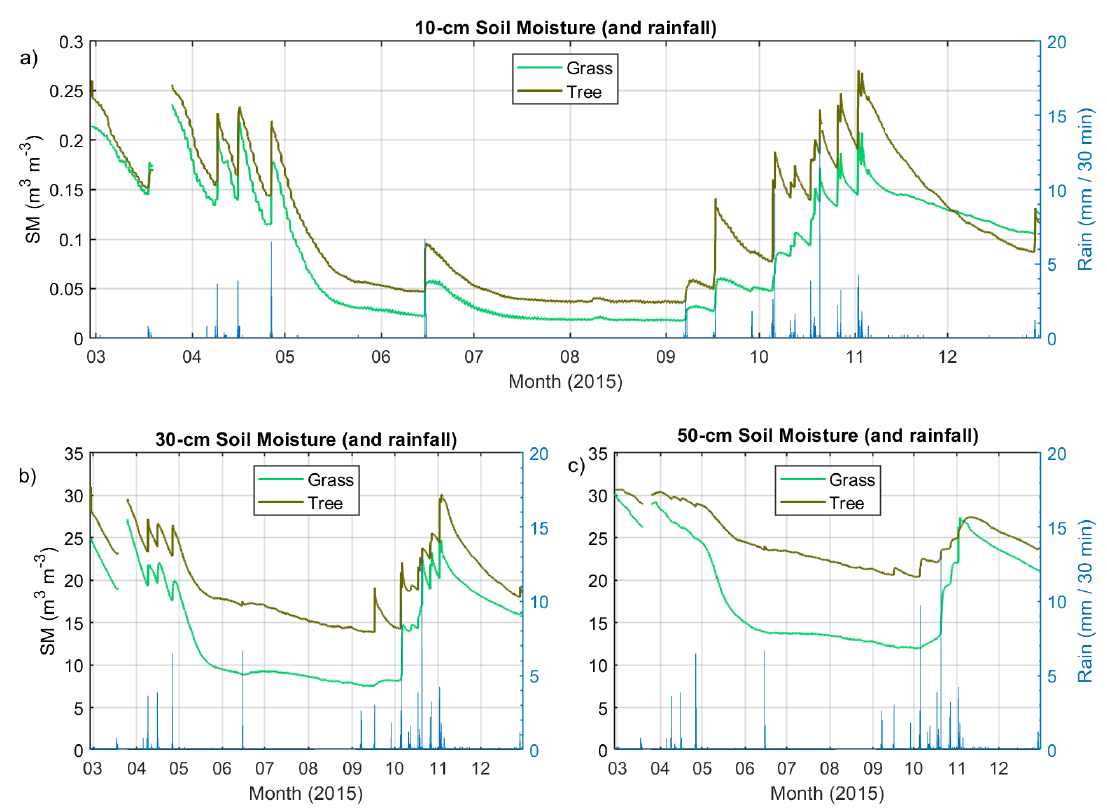
Figure 5. Soil moisture (SM) at the grass (light green) and tree (dark green) at the savanna site in Santa Clotilde : 10 cm ( a ), 30 cm ( b ), and 50 cm ( c ). The rainfall (mm/30 min) is represented with blue